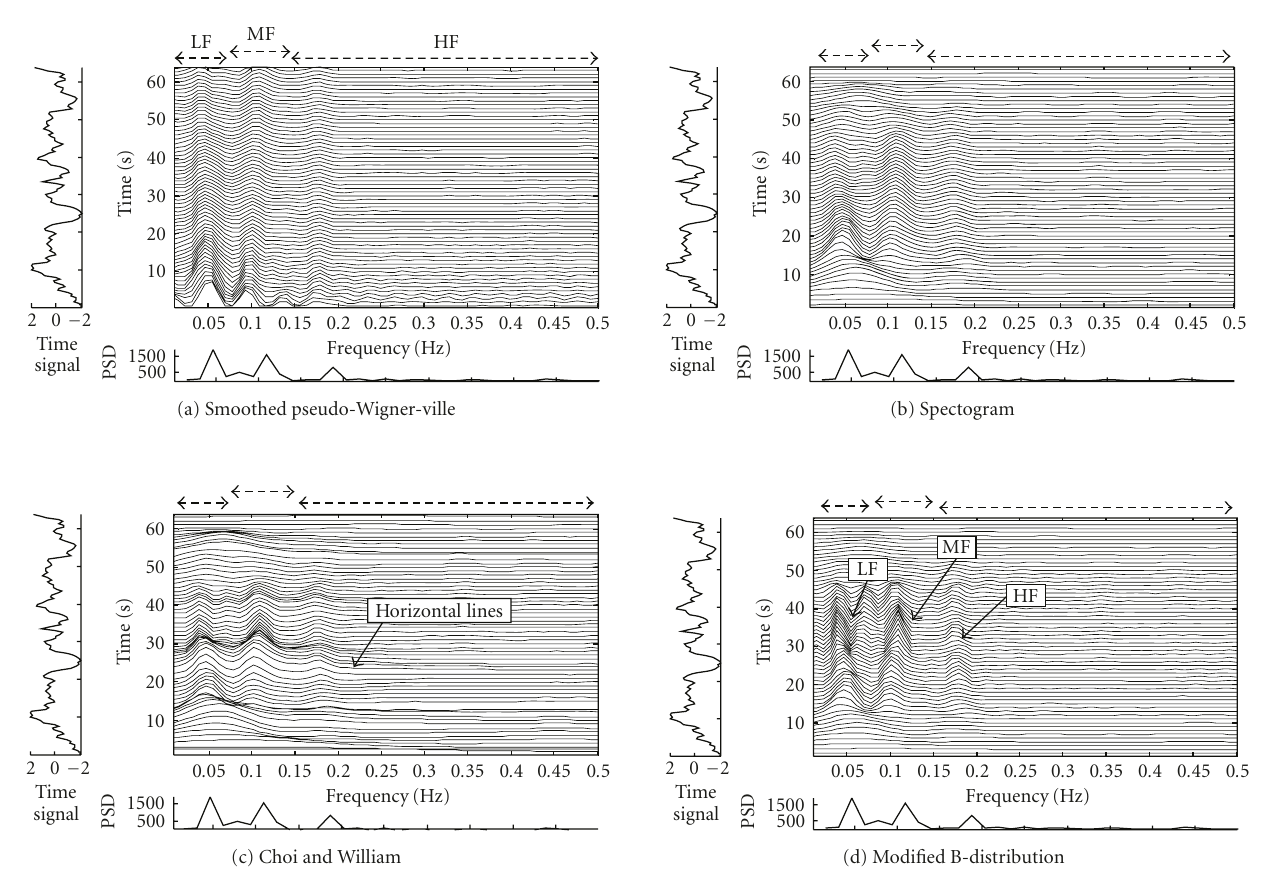
Figure 2: TFD for HRV related to nonseizure: (a) SPWVD; (b) SP; (c) CWD and (d)